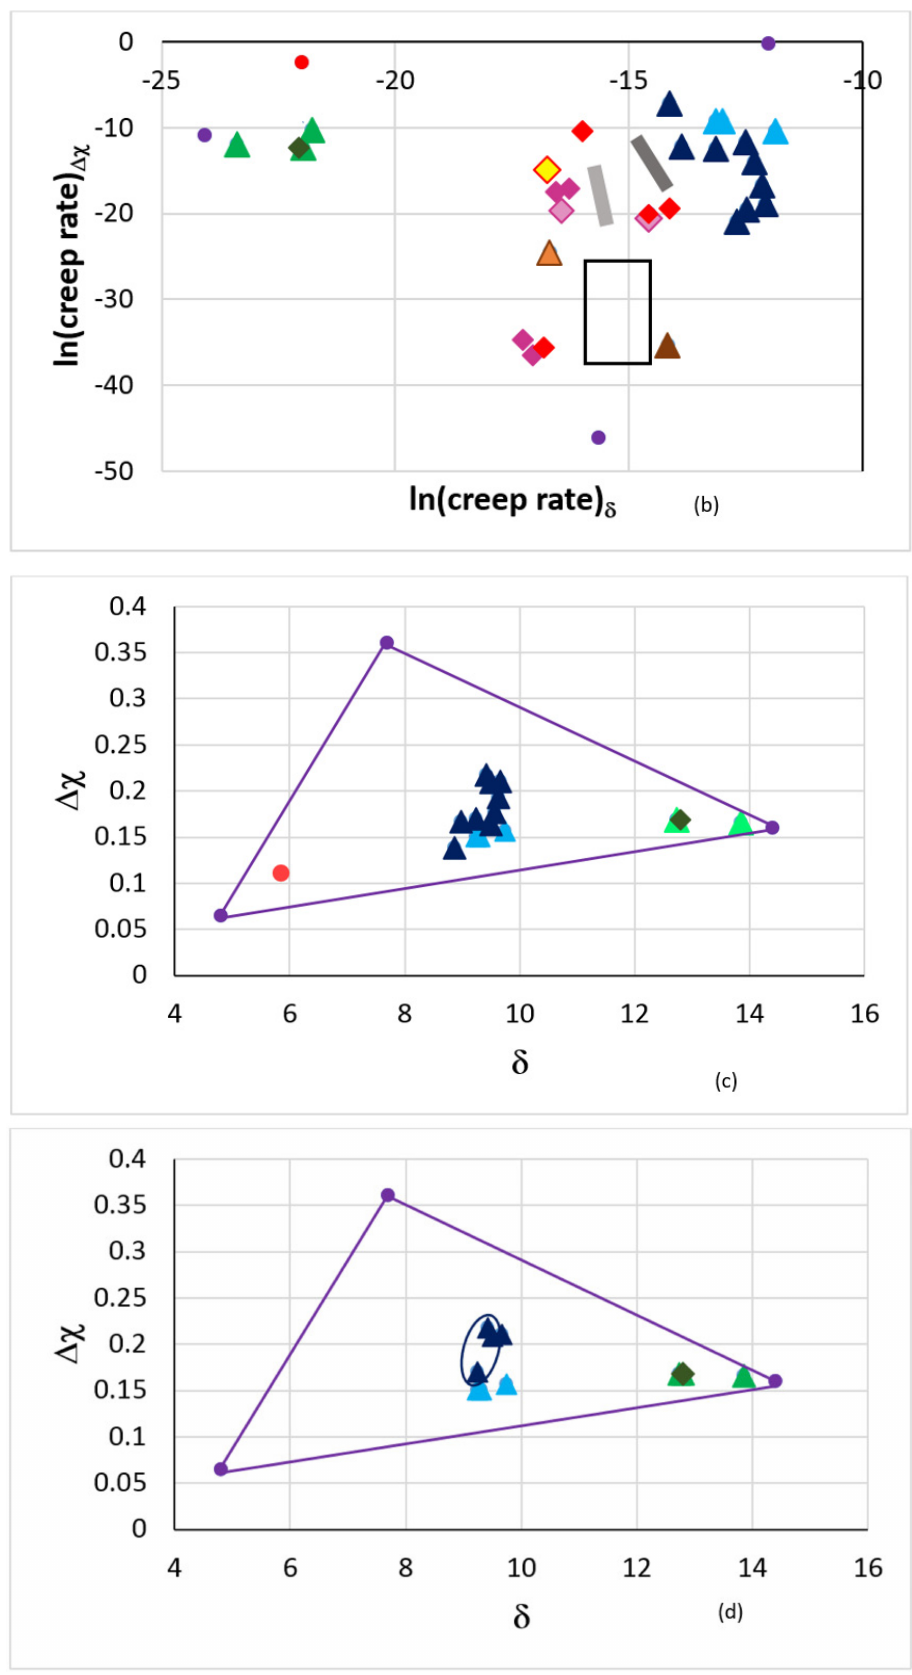
Figure 2. ( a ) ∆ χ versus δ map of selected RM(Nb)ICs, RM(Nb)ICs/RCCAs and RM(Nb)ICs/RHEAs (see text). ( b ) Map of creep rates at 1200 ◦ C and 170 MPa (creep goal conditions) of the alloys